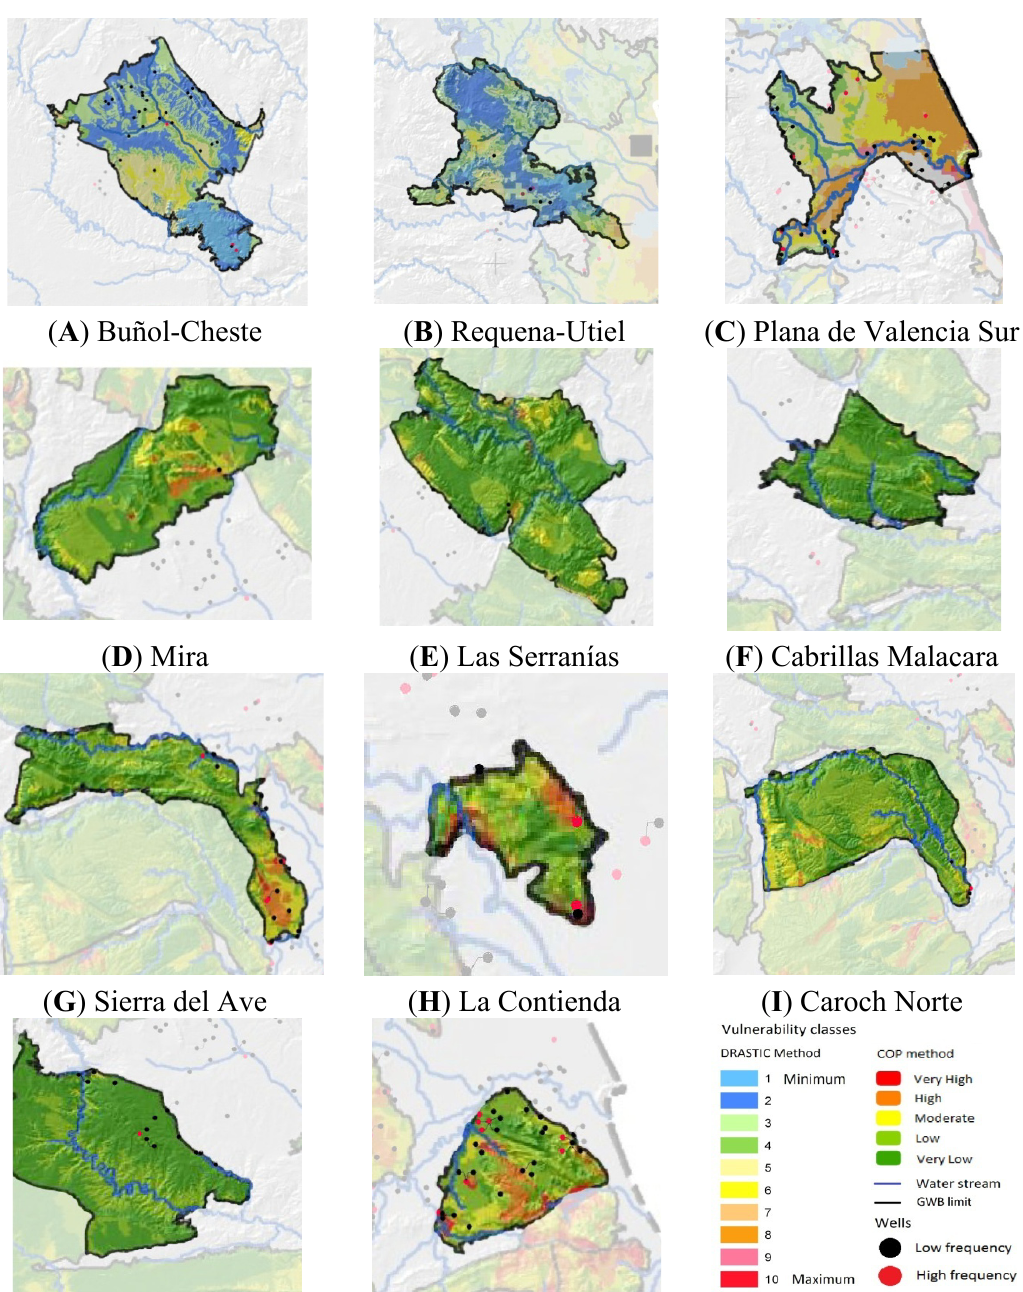
Figure 2. Distribution of wells by groundwater bodies (GBW) ( A ) Buñol-Cheste; ( B ) Requena-Utiel; ( C ) Plana de Valencia Sur; ( D ) Mira; ( E ) Las Serranías; ( F ) Cabrillas Malacara; ( G ) Sierra del Ave; ( H ) La Contienda; ( I ) Caroch Norte; ( J ) Hoces del